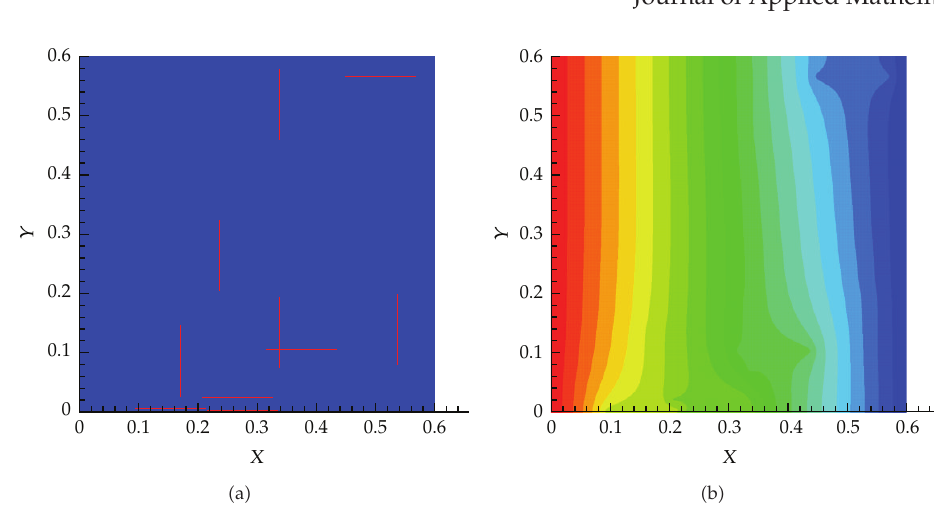
Figure 7: Fractures orientations (cid:2) 10 fractures (cid:3) and pressure contours based on the fine